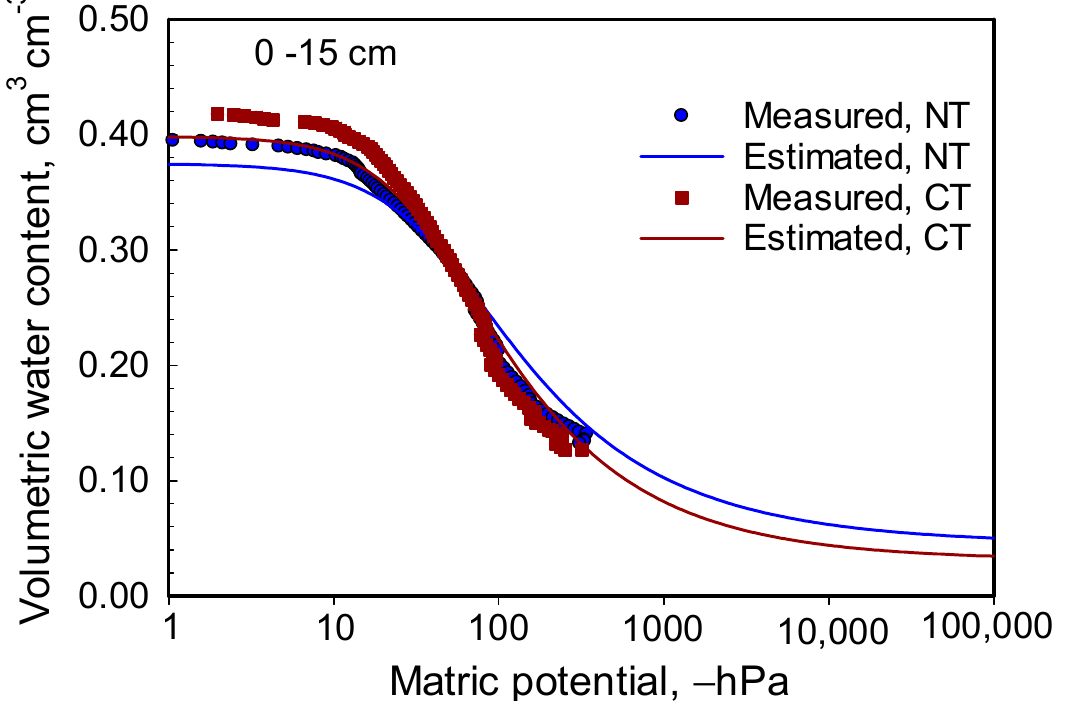
Figure 1. Soil–water retention curves for no-till (NT) and conventional tillage (CT) at a 0–15 cm soil depth.